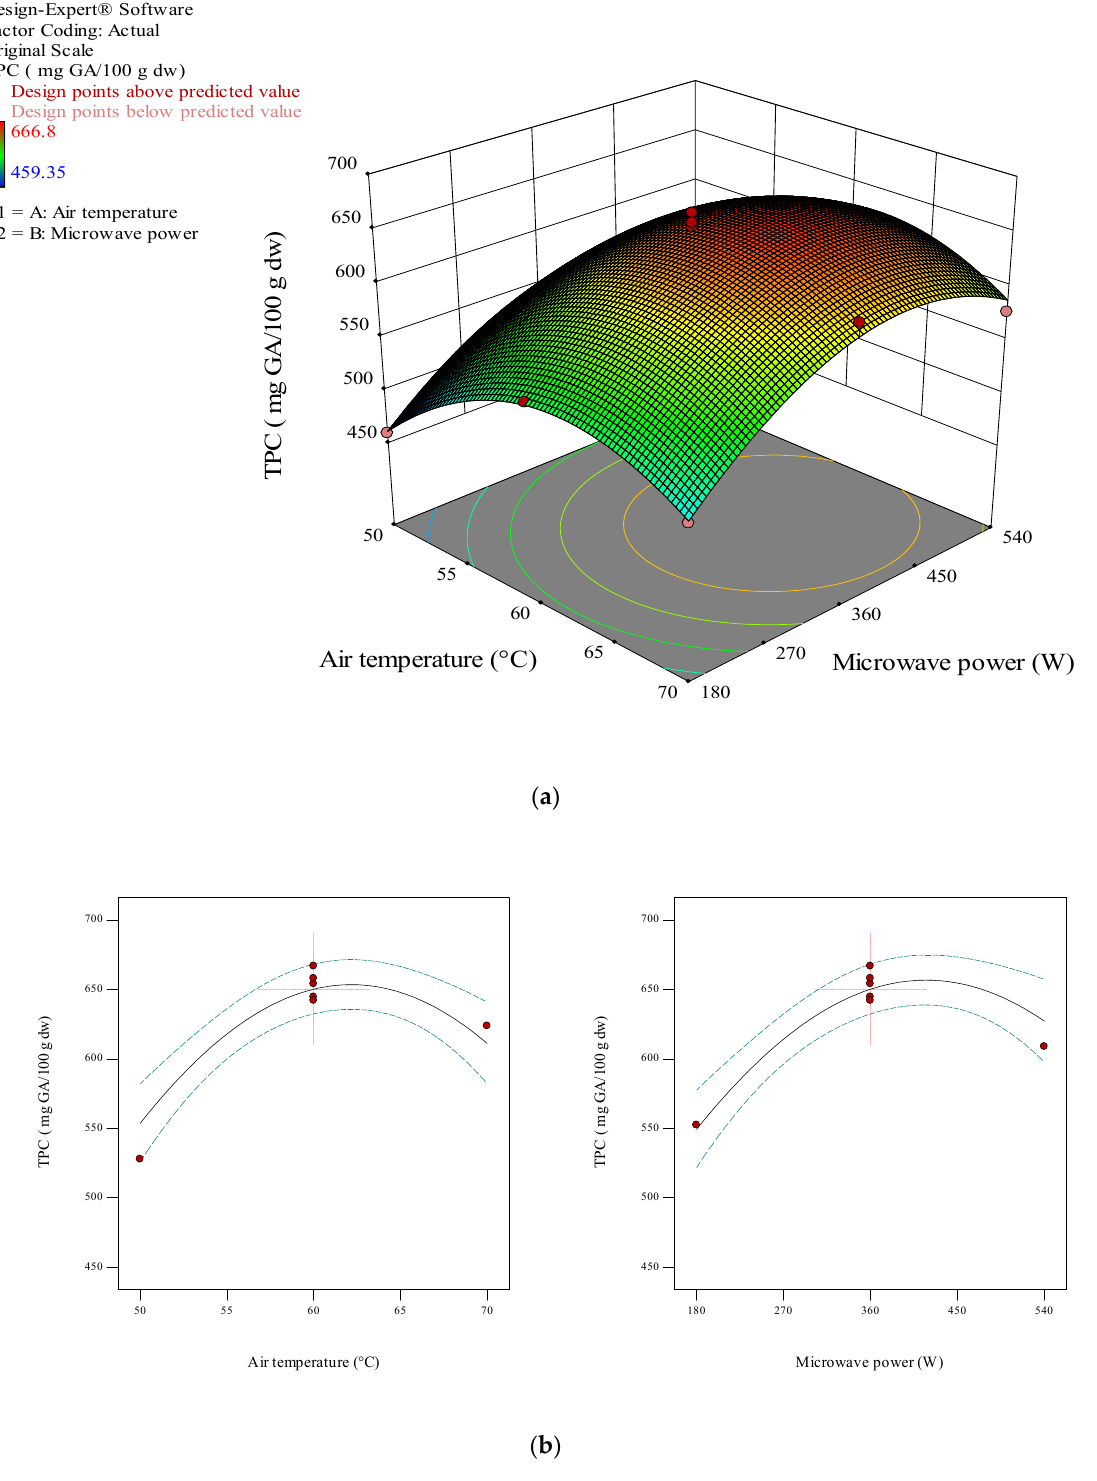
Figure 7. ( a ) The combined effect of air temperature and microwave power on TPC. ( b ) The individual effects of air temperature alone and microwave power alone on